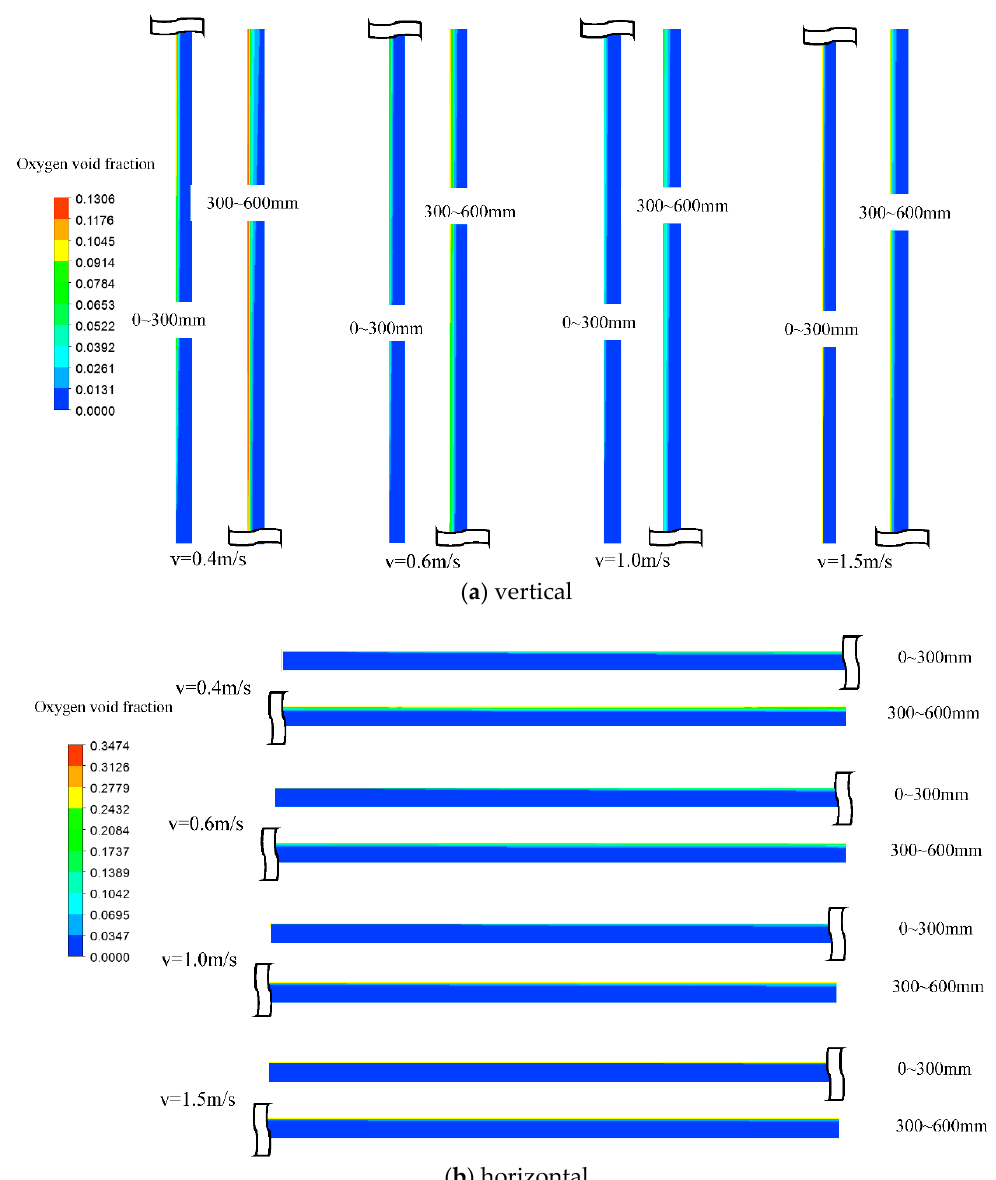
Figure 5. The oxygen void fraction contour for different vin for a vertical cell and a horizontal cell. Figure 6a–d illustrate the void fraction distributions α (x, y) vs. x (i.e., across the cell) under four different inlet electrolyte velocities, with v in = 0.4, 0.6, 1.0, and 1.5 m/s, respectively, at four different streamwise locations y (y = 100, 200, 400, and 600 mm), for a vertical cell and a horizontal electrolysis cell. The solid lines denote the results for a vertical cell, whilst the broken lines represent those from